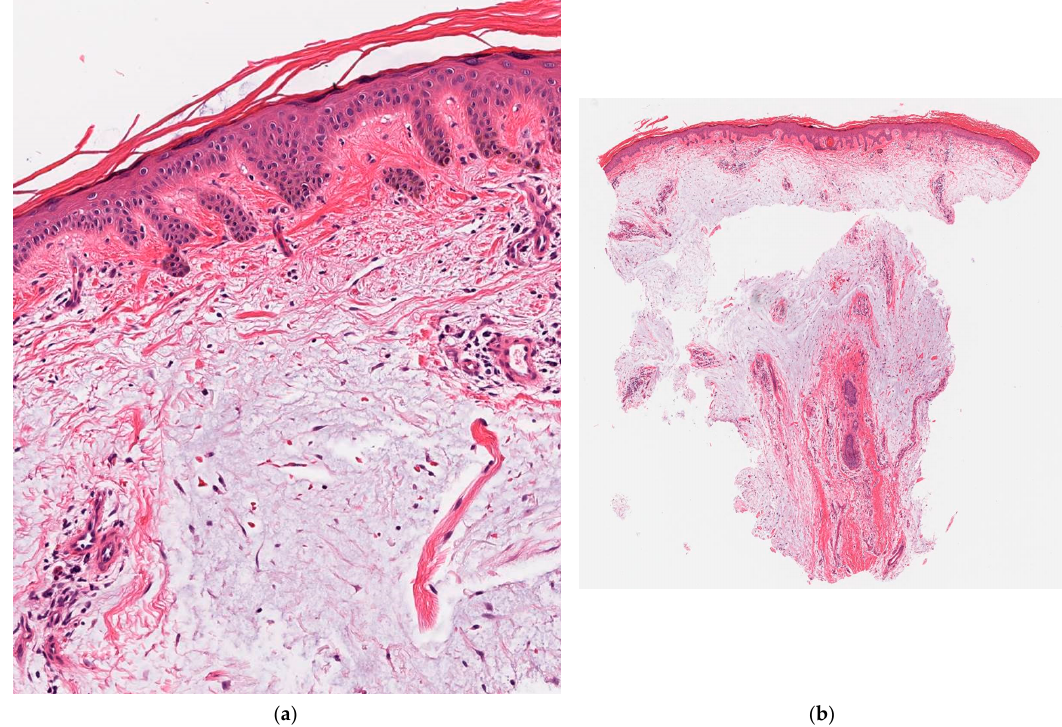
Figure 2. Hyperorthokeratosis overlying a mildly acanthotic epidermis with papillomatosis. There is significant separation of collagen bundles by large quantities of mucin with admixed fibroblasts within the dermis. ( a ) H&E ×2; ( b ) H&E ×15.